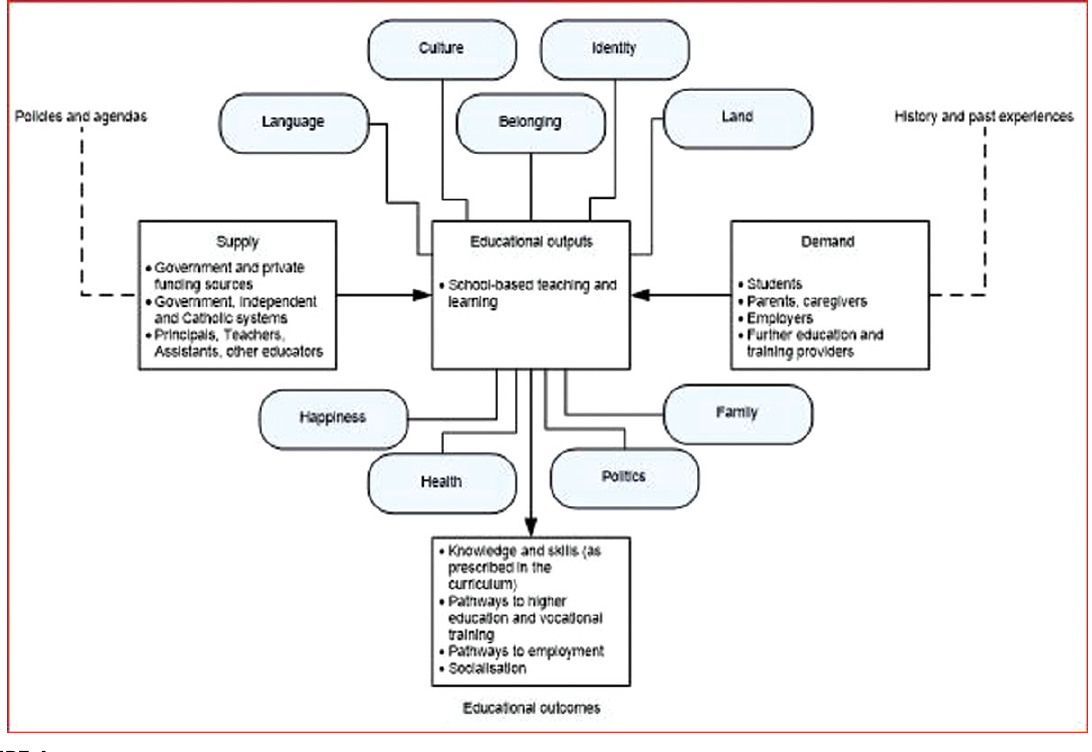
(Colour online) Belonging in the complex education system.